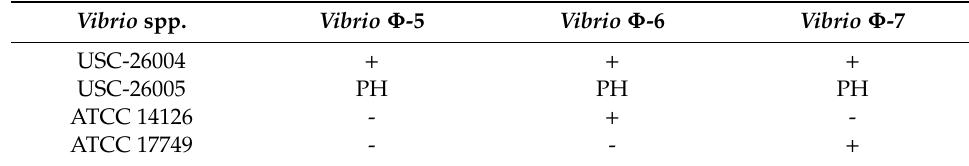
Table 3. Host range of the bacteriophage isolates determined against di ff erent Vibrio species.